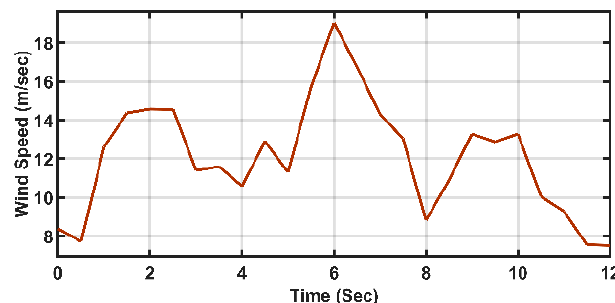
Energies 2021 , 14 , x FOR PEER REVIEW